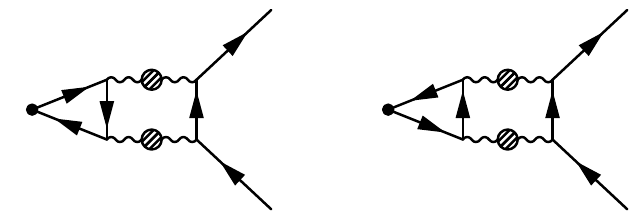
Figure 5 . The rainbow correction to the vertex.